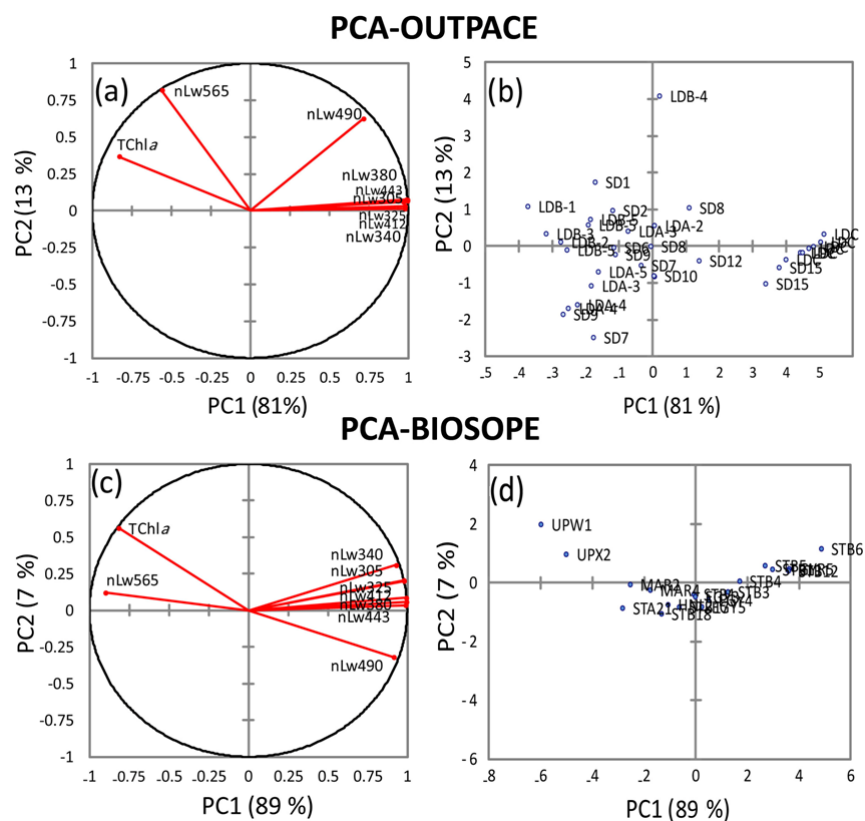
Figure 12. Principal component analysis (PCA), based on Pearson’s correlation matrices, computed on the nL w (λ) and TChl a for OUTPACE (a, b) and for BIOSOPE (c, d) . For OUTPACE (a, b) all surface data were used, including 7 days at LDA, LDB and LDC ( n = 37). For BIOSOPE, all surface data ( n = 17) were used (c, d) . Correlation circle (left panels), projection of stations on the first factorial planes (F1 and F2) (right